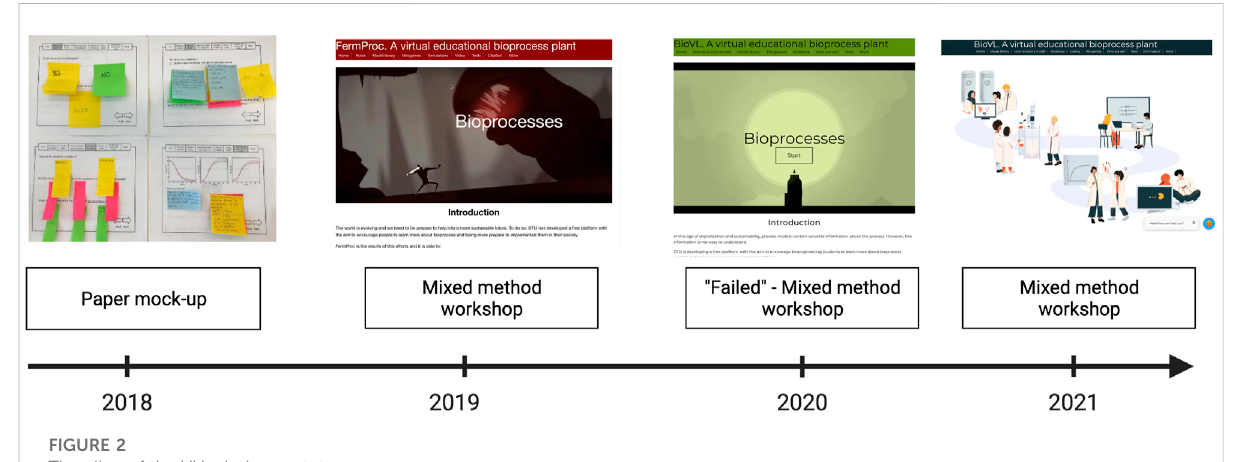
FIGURE 2 Time line of the VL ’ s design prototypes.